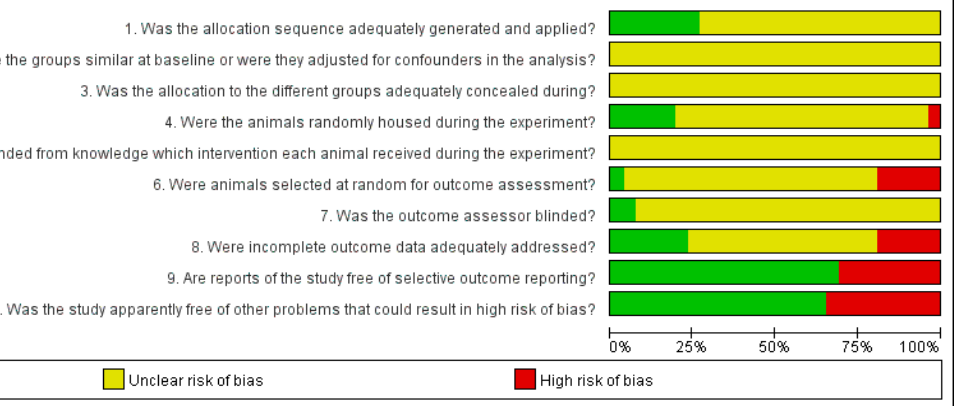
Figure 2. SYRCLE results of included animal studies.